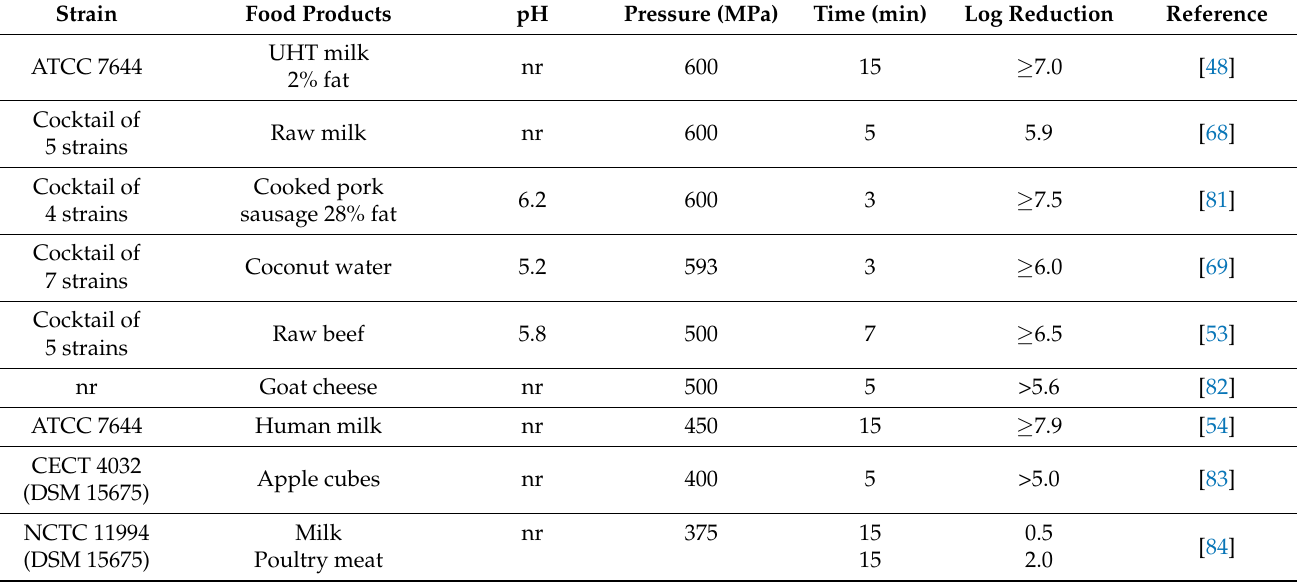
Table 3. Inactivation of Listeria monocytogenes in low-acid foods by high-pressure processing